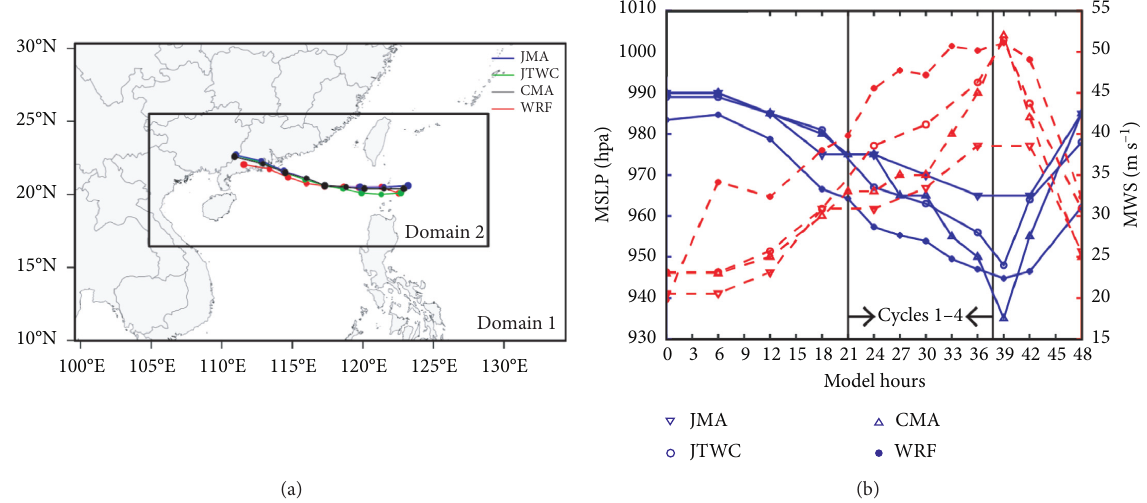
Figure 3: Model domains and Hato 6h tracks and intensities from observations and simulations between 12:00 UTC on 21 August 2017 and 12:00 UTC on 23 August 2017 (model hours 0–48). (a) Location of the domains and track observations from the Japan Meteorological Agency (JMA; blue), Joint Typhoon Warning Centre (JTWC; green), China Meteorological Administration (CMA; black), and WRF simulated track (red). (b) Minimum sea level pressure (MSLP; blue lines) and maximum 10m wind speed (MWS; red lines) from best-track databases, and the WRF simulation between the black solid lines is the analysis time from cycles 1 to 4.